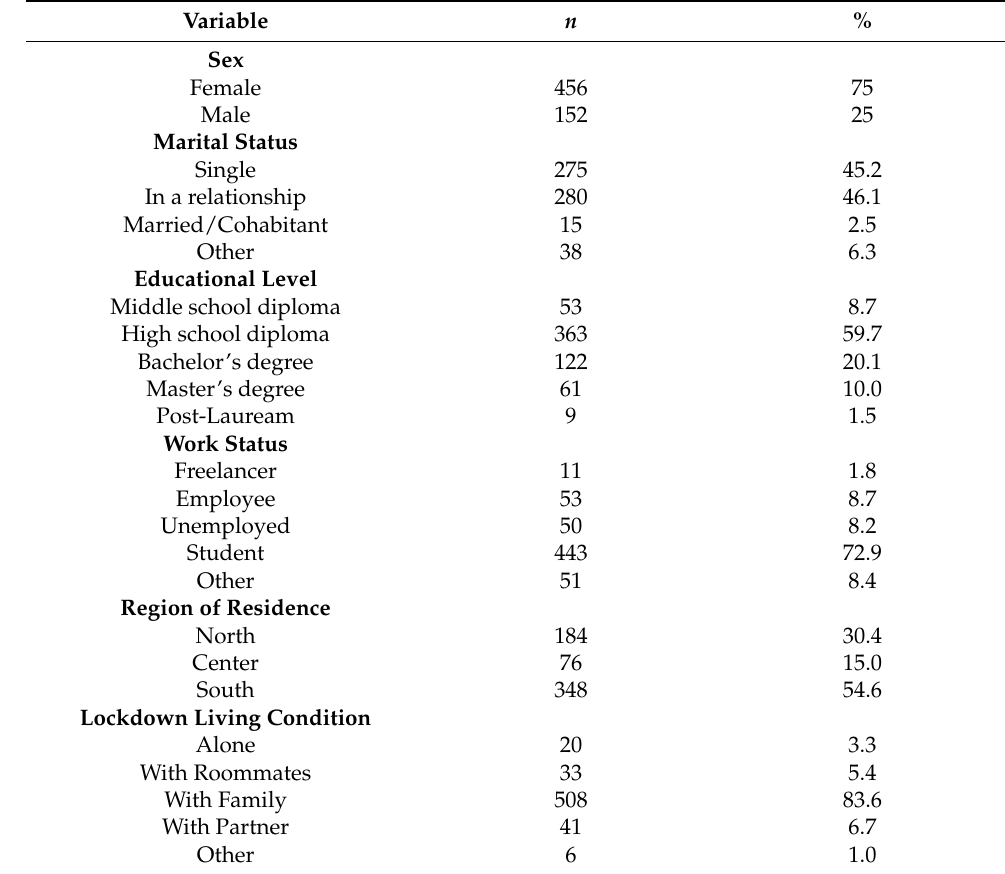
Table 1. Sociodemographic characteristics of the